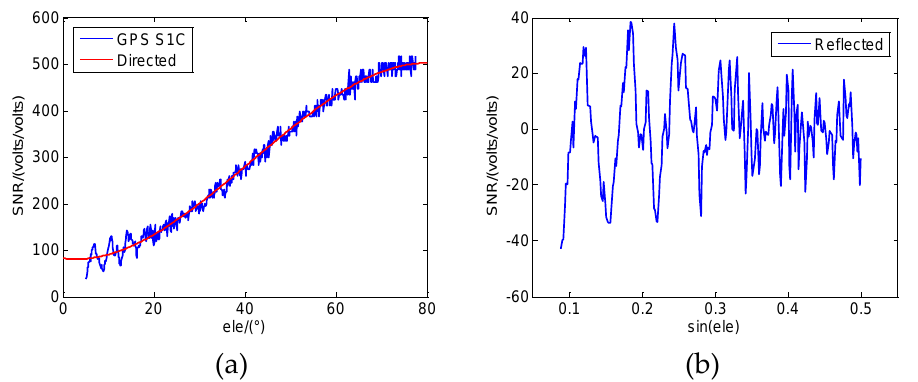
Figure 8. SNR sequence data processing: ( a ) GPS S1C SNR and direct signal fitting; ( b ) reflected signal extraction.